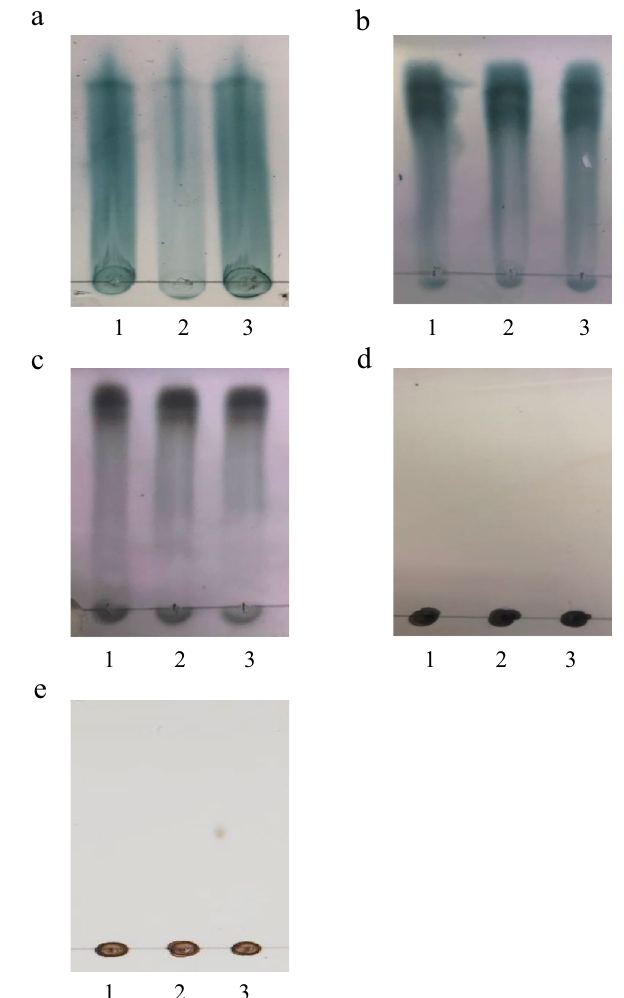
Figure 5. Extracellular amounts of oligosaccharides or polysaccharides measured by TLC. Sugar compositions of the supernatants were determined after cells of B. subtilis 168 or UT02 were densely suspended in PBS containing inulin ( a ), IMO ( b ), XOS ( c ), alginate ( d ) or levan ( e ) and incubated at 37 °C for 2 h. Lane 1, B. subtilis 168 (after 2 h); lane 2, UT02 (after 2 h); lane 3, Control (1%,